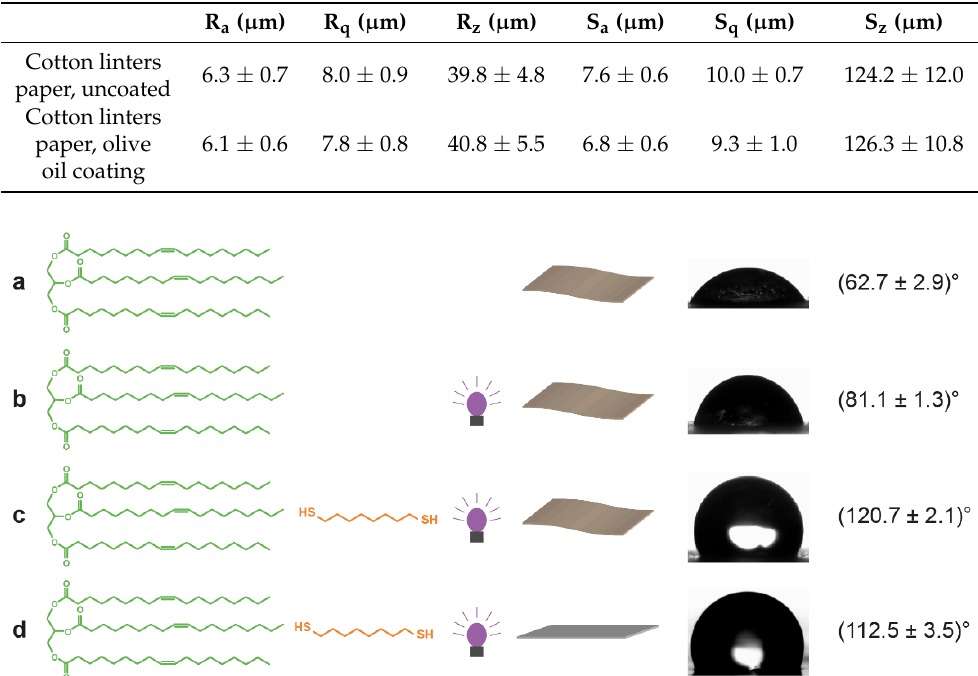
Figure 5. Surface characterization of uncoated ( a – c ) cotton linters paper and ( d – f ) cotton linters paper coated with olive oil/1,8-ODT using ( a , d ) optical microscopy, ( b , e ) SEM and ( c , f ) optical profilometry. Table 1. Roughness parameters determined from tactile profilometry (profile roughness values) and optical profilometry (surface roughness values).